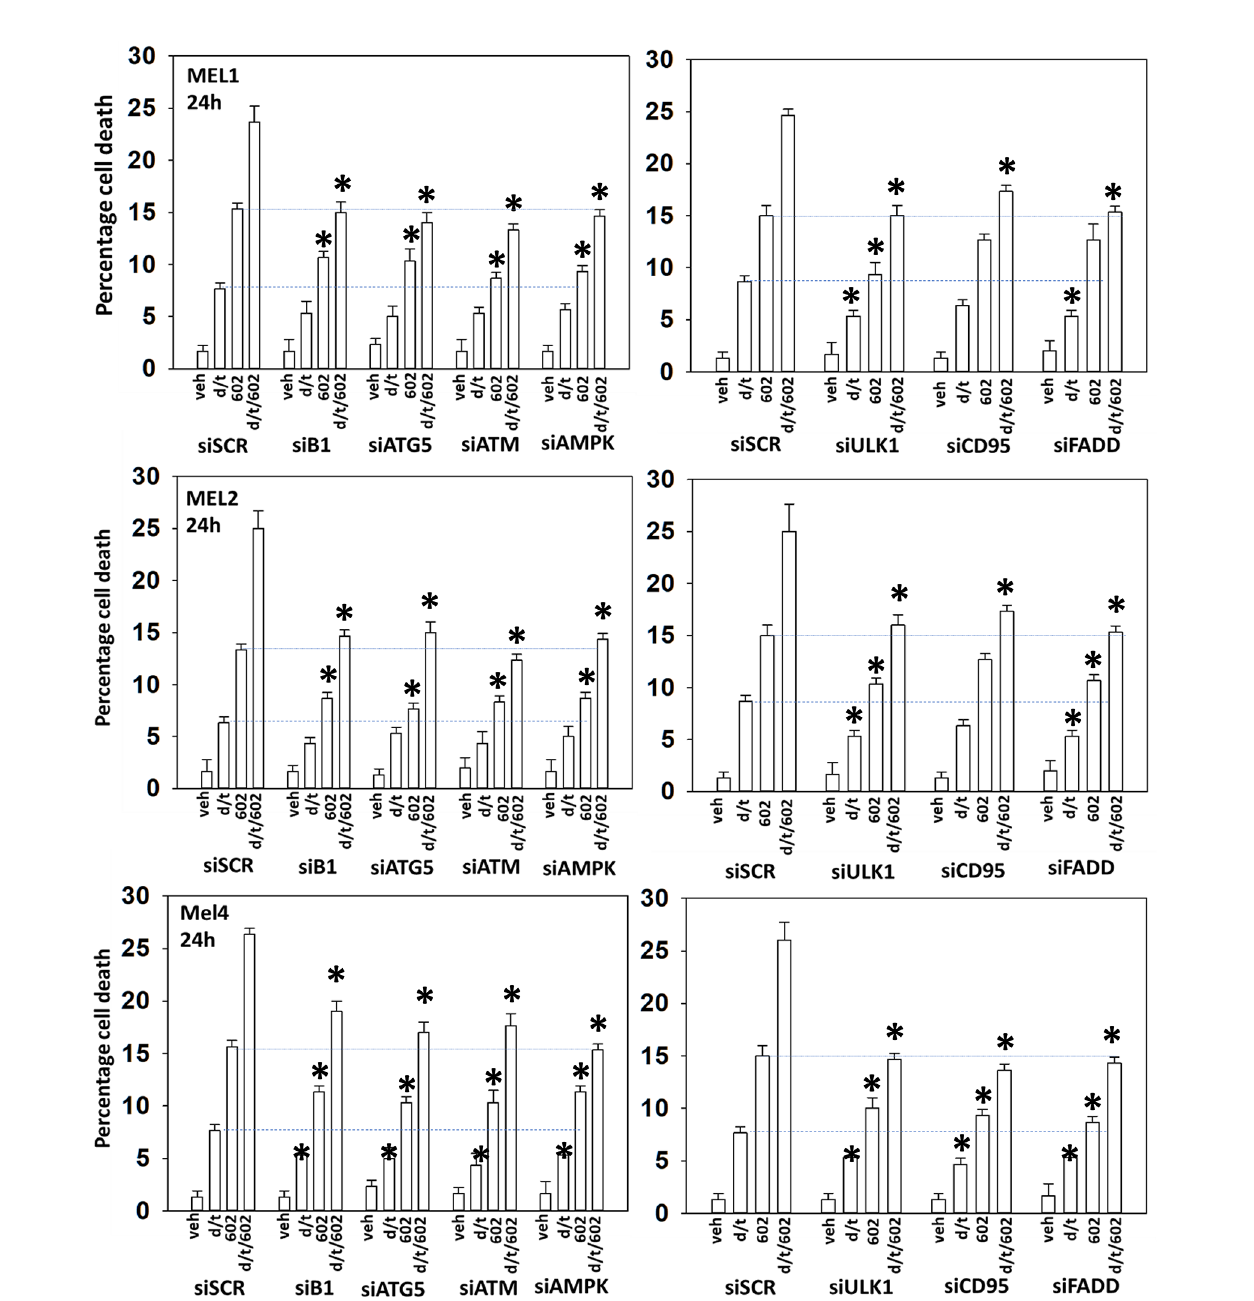
FIGURE 7 | Enhanced tumor cell killing by [GZ17-6.02 + trametinib + dabrafenib] requires autophagosome formation and CD95 death receptor signaling. Cells were transfected with a scrambled siRNA (siSCR) or with validated siRNA molecules to knock down the expression of the indicated proteins. Twenty-four h later, cells were treated with vehicle control, GZ17-6.02 [curcumin (2 µM) + isovanillin (37.2 µM) + harmine (4.5 µM)], [trametinib (t, 2 µM) + dabrafenib (d, 2 µM)] or the drugs in combination for 24h. Cells were isolated and viability determined by trypan blue exclusion (n = 3 +/- SD). *p < 0.05 less than corresponding value in siSCR transfected